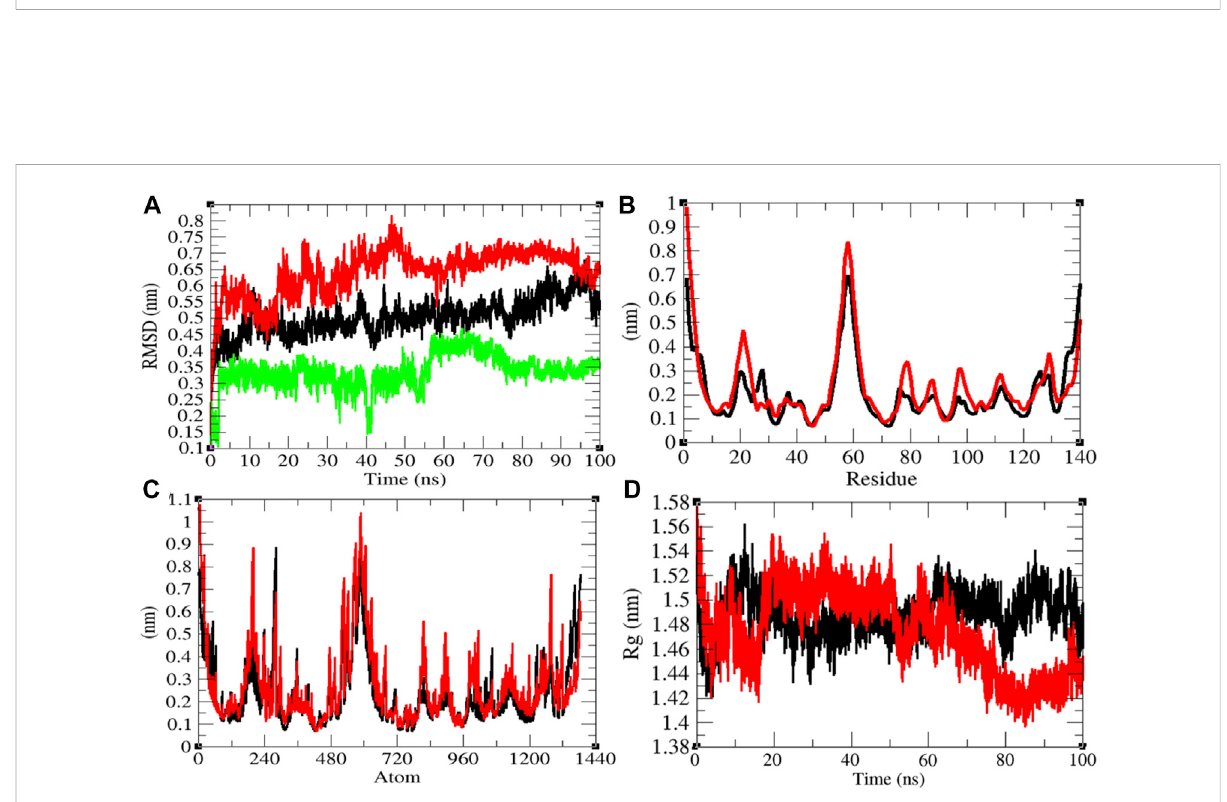
StructuraldynamicsofNTD. (A) RootmeansquaredeviationsplotforNTD(black),NTD-remdesivir(red),andremdesivir(green)asafunctionof time. (B) Root mean square fl uctuations vs. residues. (C) Root mean square fl uctuations vs. atoms. (D) Radius of gyration ( R g )